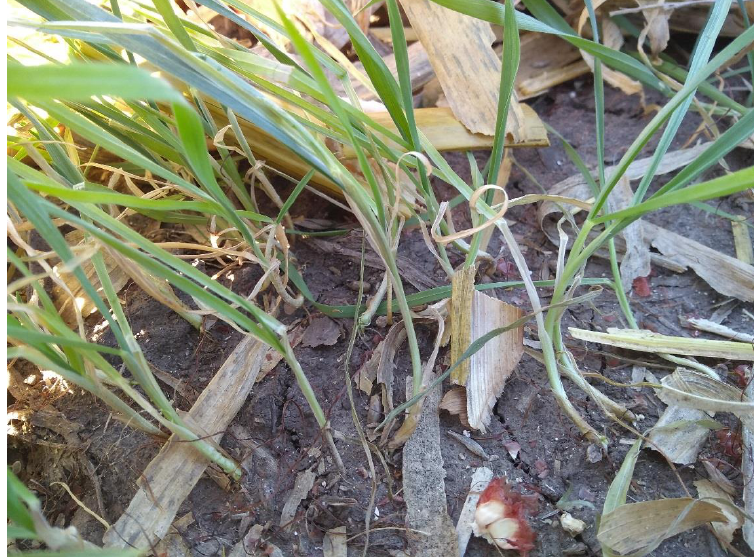
Figure 3. Rye at Mead 70 days after broadcasting into corn. Rye was seeded 19 September; picture was taken 30 November 2017. Note lack of tillers, elongated stems, and light-green color. Corn residue was removed before taking picture.